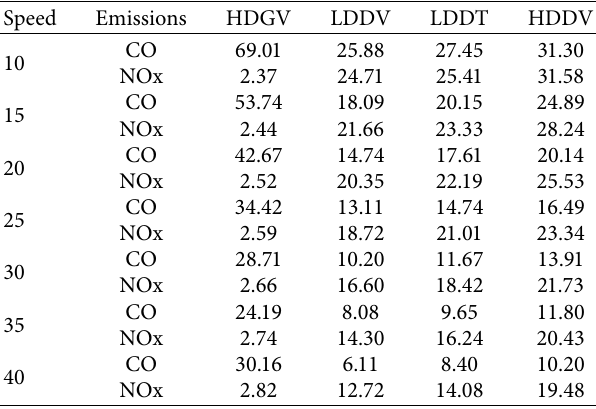
Table 1: The factors of exhaust emission at different speeds (g/km). Speed